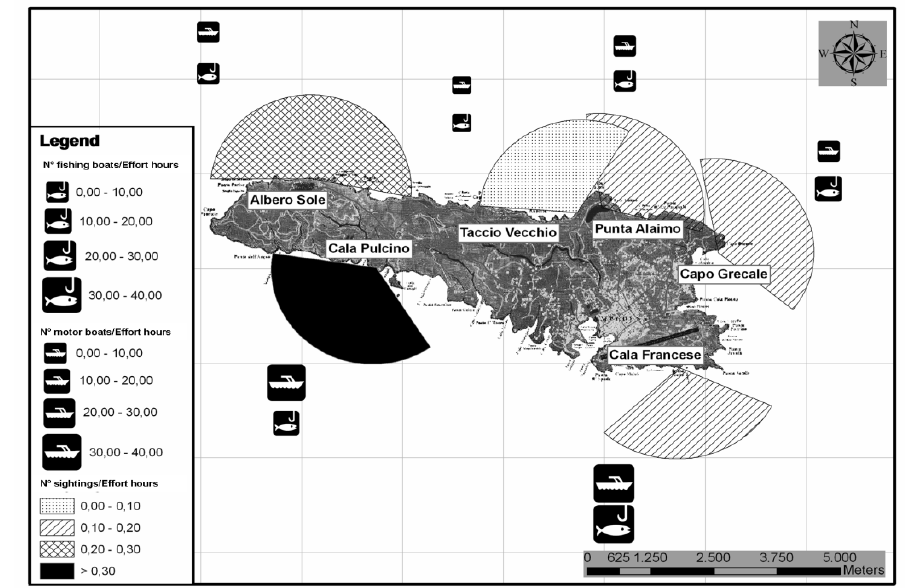
Figure 2. Sighting frequency, boat presence and open view sea sectors using land-based survey. The spatial grid used in the figure is composed by cells of 1 nm 2 .